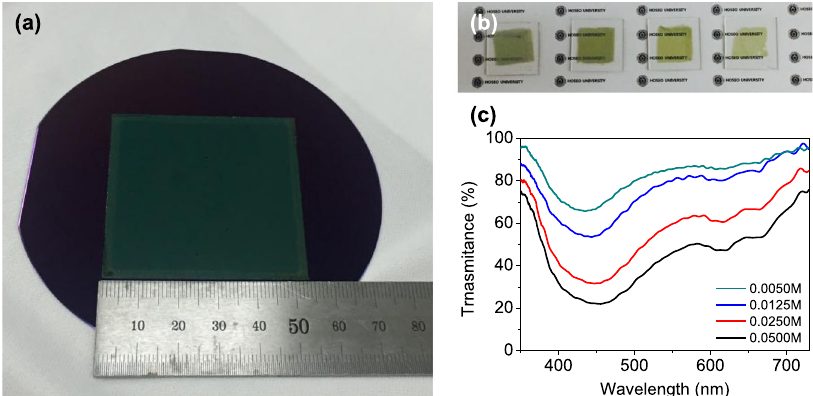
Fig. 5 Transferred MoS 2 and transmittance property. a Transferred MoS 2 of 5 × 5 cm on a substrate, b transferred MoS 2 with various concentrations on glass substrate, and c transmittance of MoS 2 thin fi lms on glass with